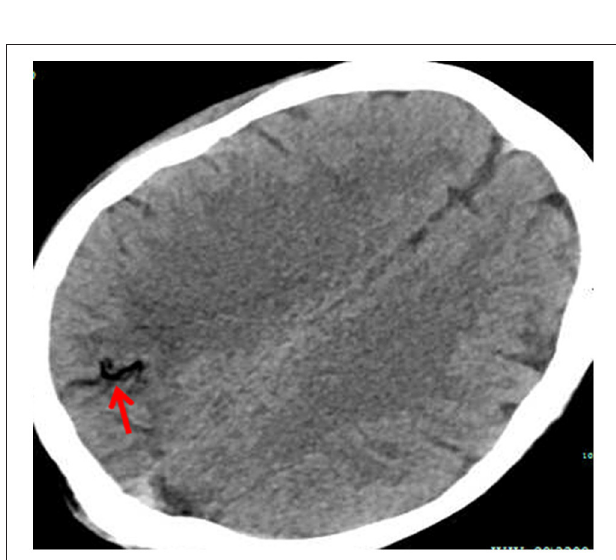
FIGURE 5 | A brain CT scan showed multiple low densities in the right occipital lobe (red